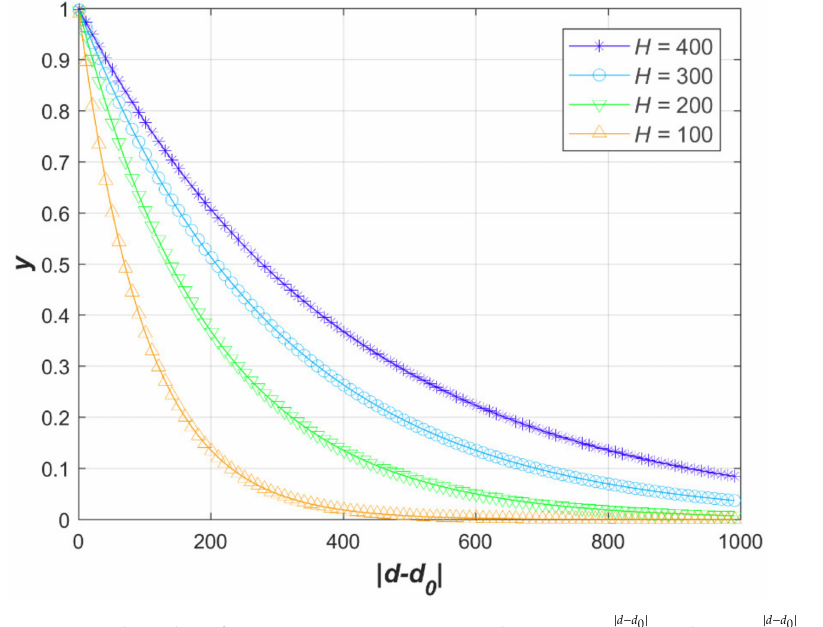
Figure 3. Memory-based preference attenuation curve, where y = e −